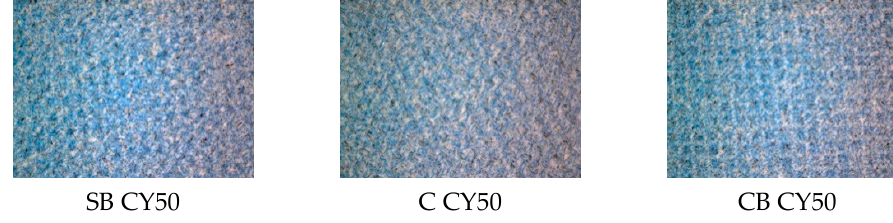
Figure 8. Microscopic images of samples printed in cyan colour hue, before and after the 10th washing cycle.